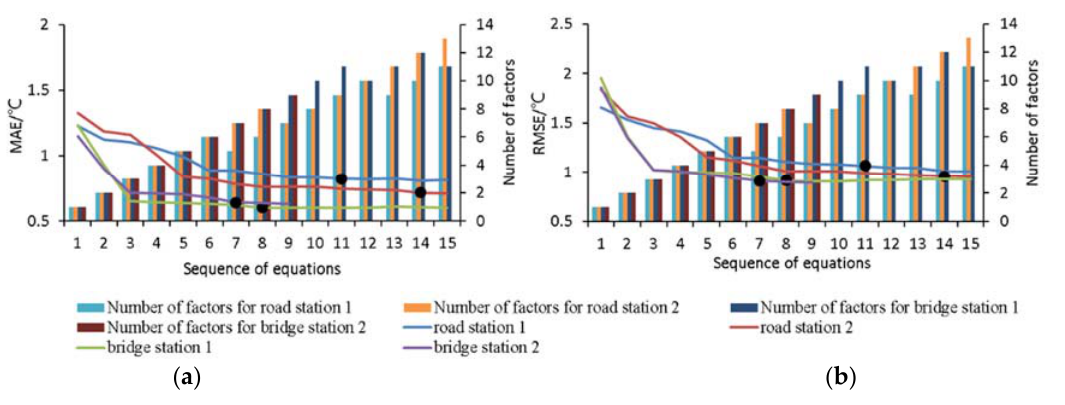
Figure 6. MAE ( a ) and RMSE ( b ) for the stepwise regression models sorted by RMSE in reverse order (line: MAE and RMSE for each model; bar: number of factors in each model; • selected models).